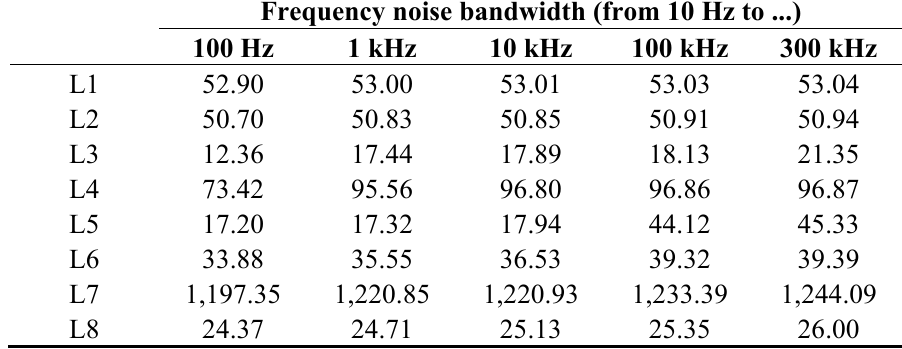
Table 4. RMS values of frequency noise vs . frequency bandwidth [kHz/(Hz) 1/2 ]. Starting frequency of the considered band is 10